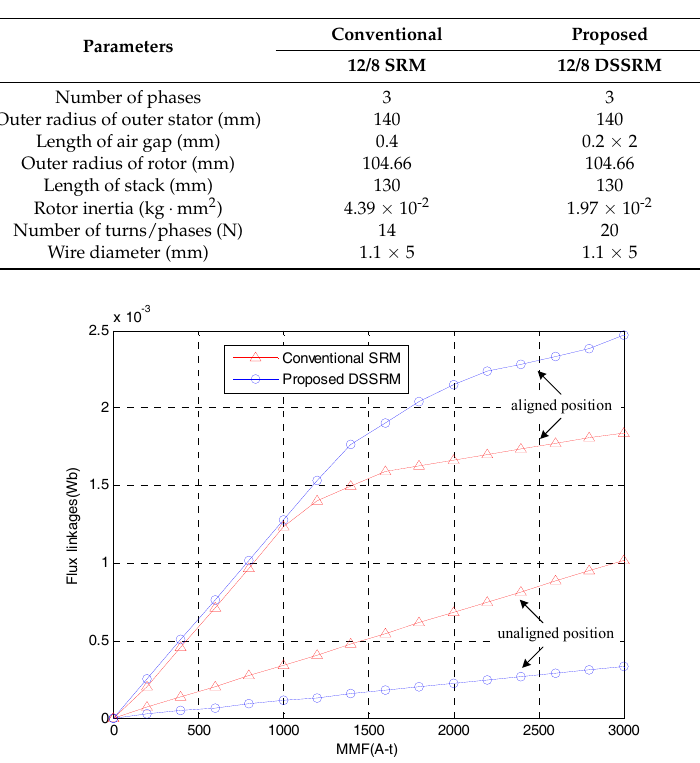
Table 2. Parameters of conventional SRM and proposed DSSRM.